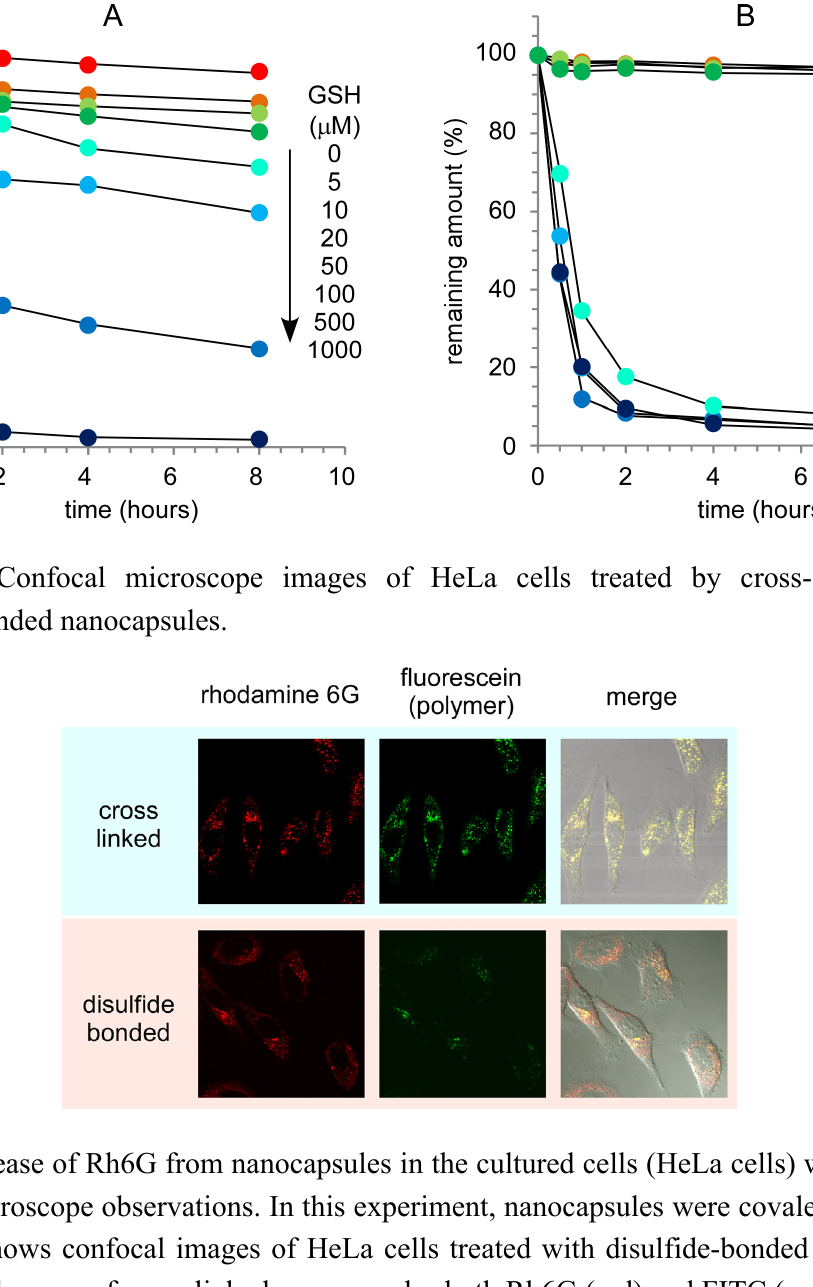
Figure 7. Effect of glutathione concentration on the stability of disulfide-bonded